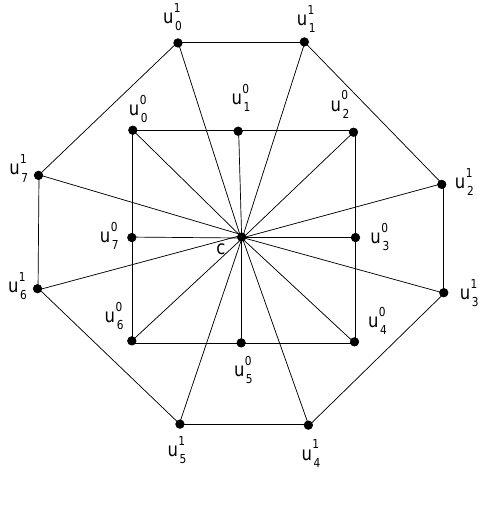
Figure 2. Multiple wheel graph 2 W